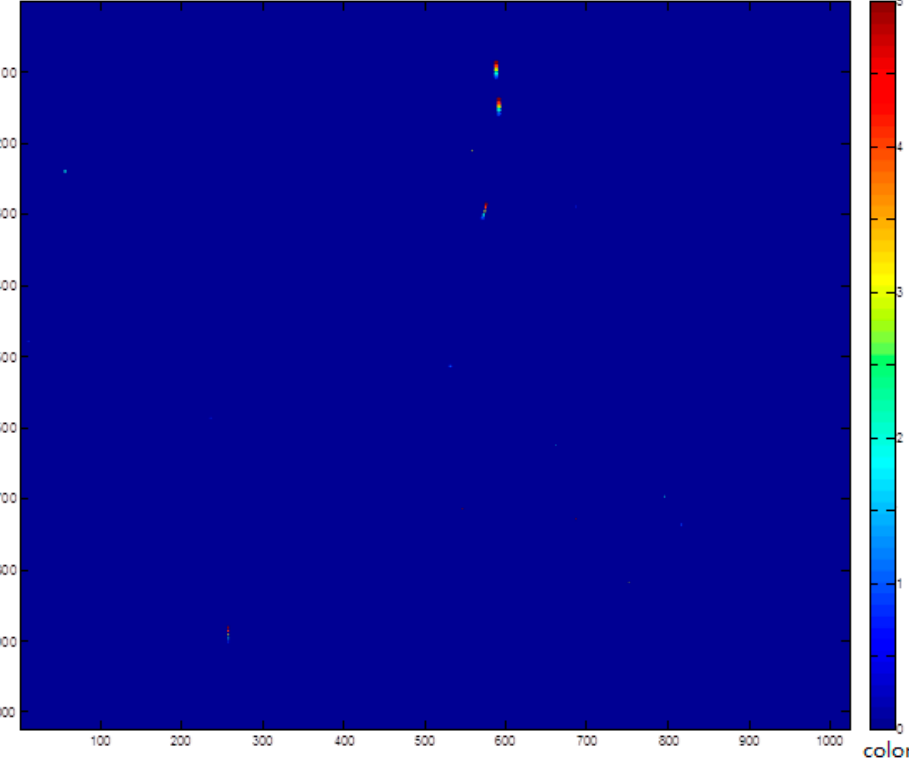
Figure 8. Time information frame after stellar removal.